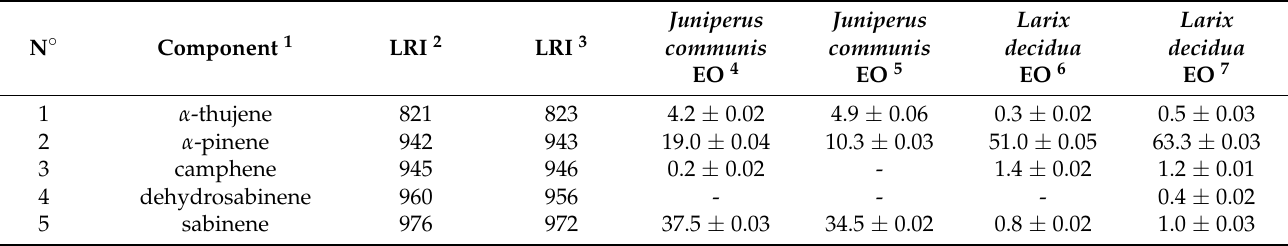
Table 1. Chemical composition (percentages mean values ± standard deviation) of EO liquid and vapor